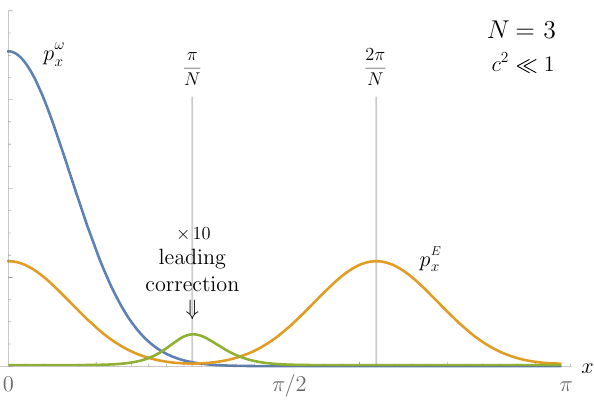
has a structure of several peaks in x ∈ [ − π, π ] obtained by multiplying p ω by 1 /N Figure 6. p E x x and adding displaced copies with periodicity 2 π/N . The comparison of the two peaks of these distributions at x = 0 give the main log N contribution. The leading correction comes from the comparison between the x = 0 peak of p ω and the first displaced peak in p E at x = 2 π/N . The x x main contribution to the relative entropy correction (whose density is plotted in green) is located half way between these peaks. The N = 3 case is shown in the figure. The functions are even in x so we only plot for x ∈ [0 , π ]